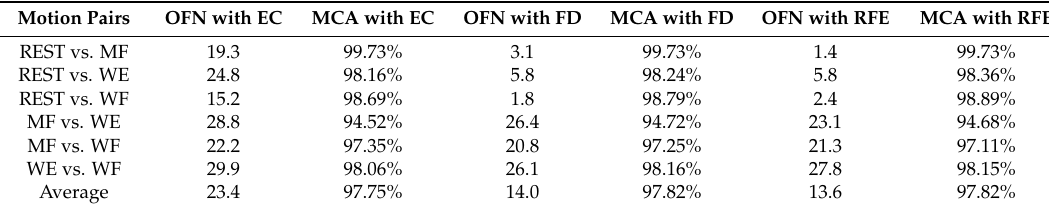
Table 6. Mean optimal feature numbers and classification accuracies of the channel ECU. Motion